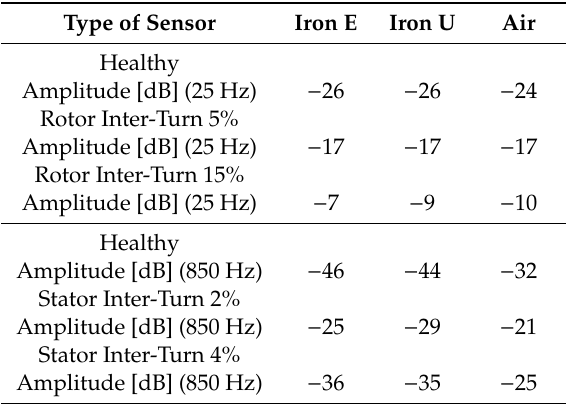
Table 5. Summary of the